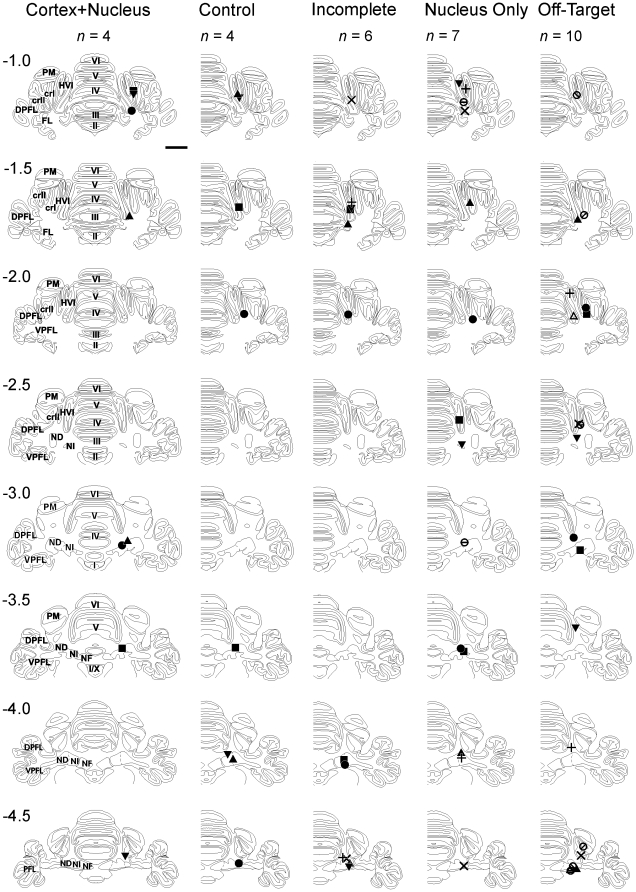
Histological reconstruction of cortical and nuclear infusion sites.Cannula tip locations are shown for all subjects in each group on a series of 8 standard transverse sections at levels from −1.0 mm to −4.5 mm relative to skull lambda. For each subject in the five groups, two matching symbols indicates the location of the cortical and nuclear cannula tips. For example, one subject in the Cortex+Nucleus group has cannula positions indicated by filled circles – the cortical placement is seen at level −1.0 mm and the nuclear placement at level −3.0 mm. The scale bar indicates 5 mm. The separation of the two cannula tip locations may be judged by reference to distances in the rostro-caudal axis and transverse planes. Abbreviations: crI and crII - crus 1 and 2 (of ansiform lobe); DPFL - dorsal paraflocculus; FL - flocculus; HIV-V, HVI - hemispheral lobules 4–5 and 6 (of Larsell); ND - dentate nucleus; NF - fastigial nucleus; NI - interpositus nucleus; PM - paramedian lobe; VPFL - ventral paraflocculus; II-X vermis lobules 2–10 (of Larsell).